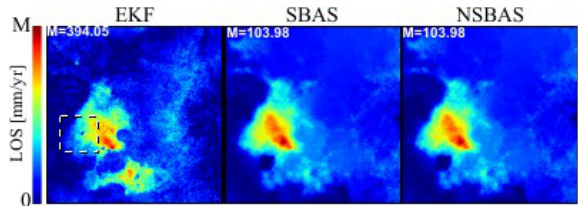
Figure 6 : The dashed interferograms have temporal baselines of more than 175 days. PSI master image is shown in red.